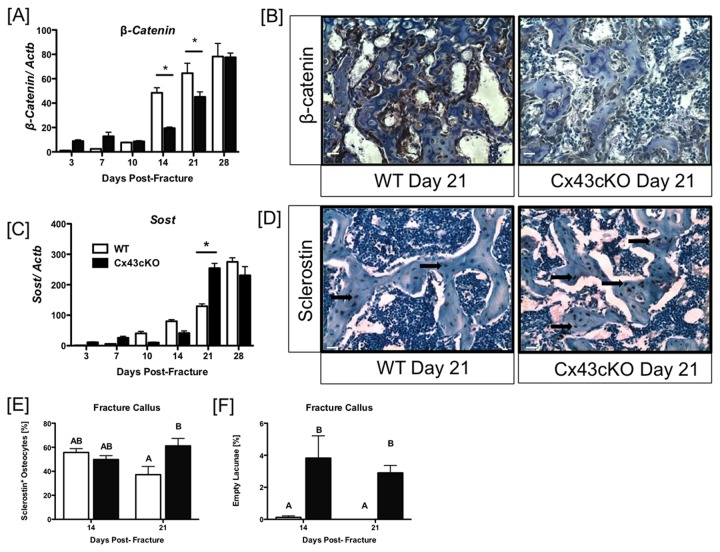
Attenuated β-catenin and enhanced Sclerostin expression in Cx43cKO fractures.[A -D] Quantitative and immunohistochemical expression of [A & B] β-catenin and [C &D] Sclerostin (Sost) in WT and Cx43cKO fracture calluses. Tissue for qPCR analysis was harvested between 3-28 days fracture. Tissue was pooled from 3 specimens/ genotype/ time-point, (*) indicates p<0.05 between WT and Cx43cKO at a given time-point. Immunohistochemistry images are 20x magnification from 21 days post-fracture; scale bar represents 100 microns. Arrows indicate Sclerostin+ cells. [E & F] Quantification of [E] Sclerostin+ osteocytes and [F] empty lacunae in the fracture callus of WT and Cx43cKO mice at 14 and 21 days. Different letters indicate p<0.05, while the same letter indicates p>0.05 between groups. n=3 specimens/ genotype/ time-point.